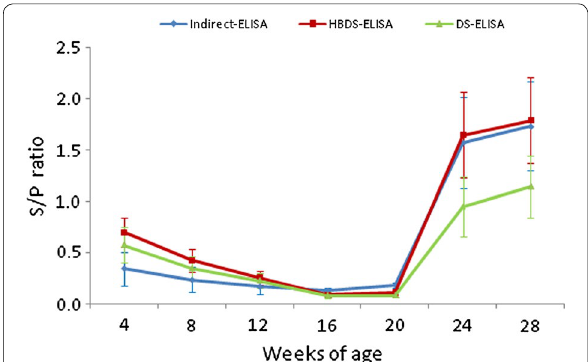
Fig. 4 Mean PCV2 specific serum antibody titers of the nine naturally infected with PCV2. Standard deviations are indicated by the error bars. The S/P cutoffs of the HBDS‑ELISA, DS‑ELISA and Indirect ELISA were 0.2, 0.27 and 0.35, respectively